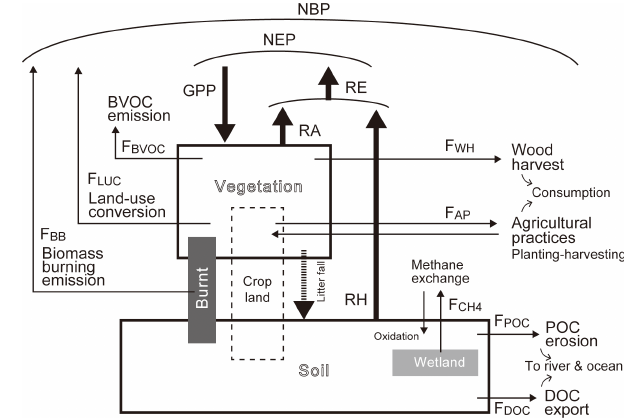
Figure 1. Schematic diagram of the carbon budget of the terrestrial ecosystem as simulated in this study. Thick lines show major carbon flows, and thin lines show minor carbon